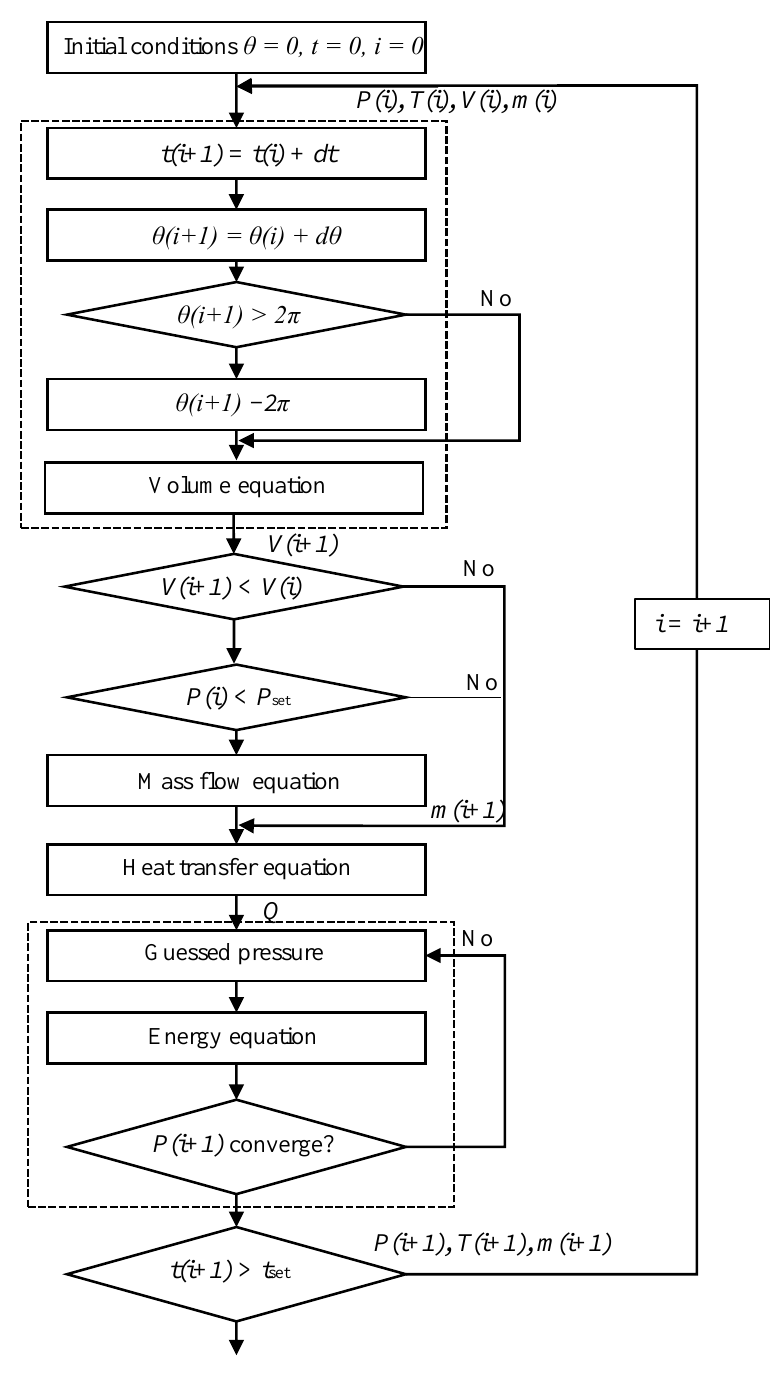
Figure 6. The flowchart for the model algorithm.